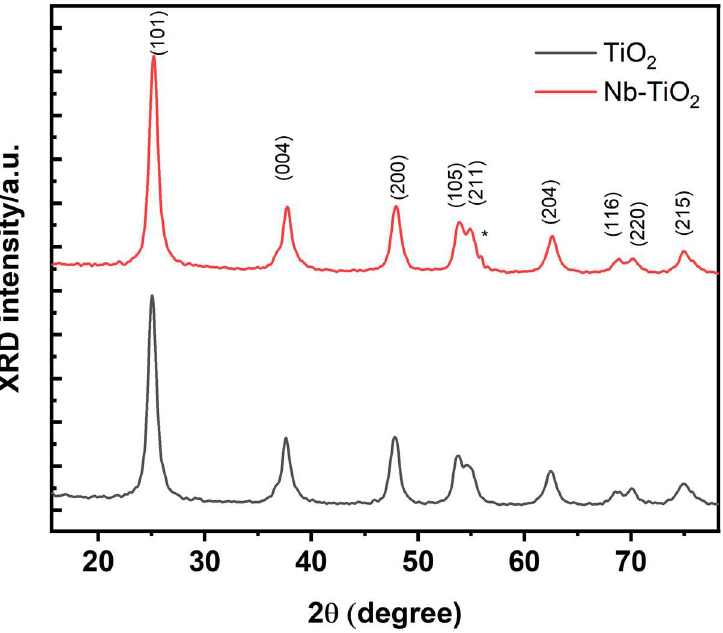
Figure 4. XRD patterns of the TiO 2 and Nb-TiO 2 samples. * represents the peak located at 55.96 in Nb-TiO 2 that corresponded to the crystal plane of niobium oxide